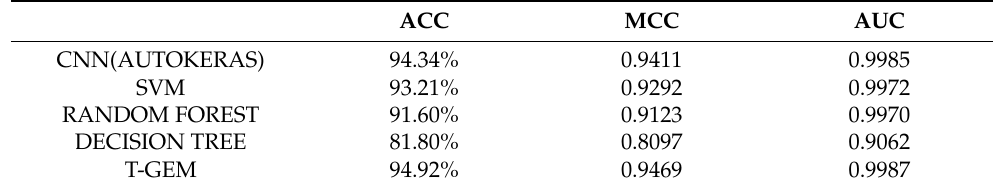
Table 2. Performances of T-GEM and the benchmark models for TCGA cancer type classification. ACC MCC AUC CNN(AUTOKERAS) 94.34% 0.9411 0.9985 SVM 93.21% 0.9292 0.9972 RANDOM FOREST 91.60% 0.9123 0.9970 DECISION TREE 81.80% 0.8097 0.9062 T-GEM 94.92% 0.9469